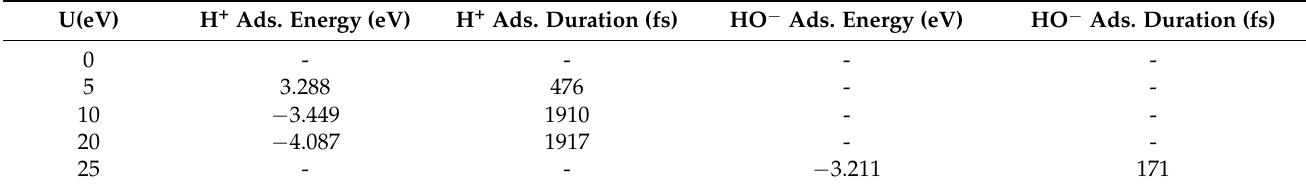
Table 8. H + Adsorption energies inside (16,0) CNT in the presence of salt.